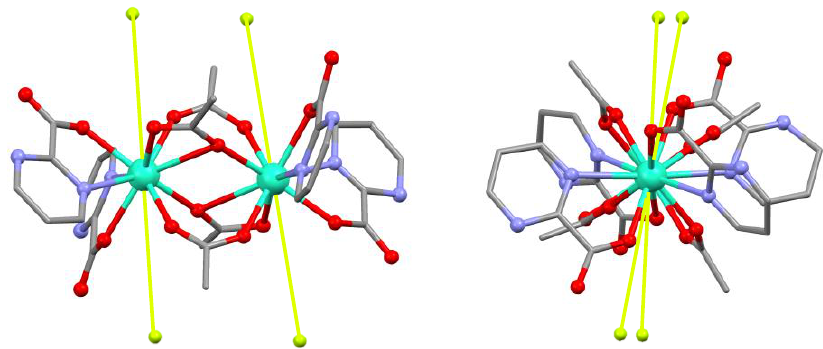
Figure 6. Two perspective views of the magnetic axes of Dy 3+ ions calculated with the Magellan software. A reduced dinuclear fragment of the structure was considered in order to perform the calculation. Hydrogen atoms are omitted for the sake of clarity.